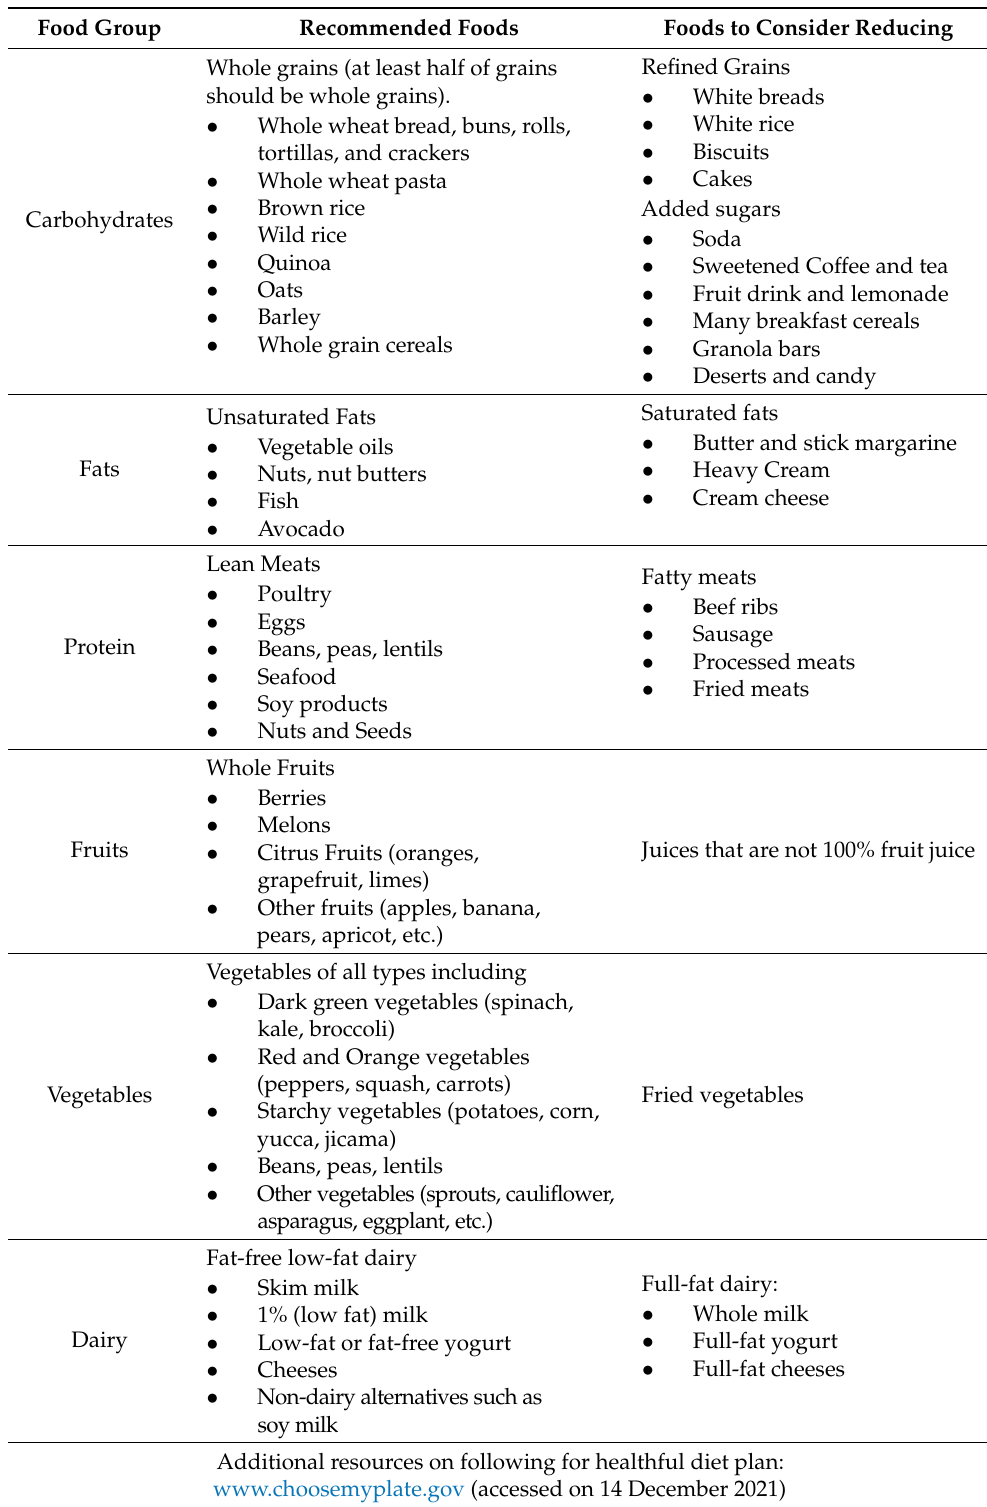
Table 3. Dietary modifications for a generally healthful eating pattern. Food Group Recommended Foods Foods to Consider Reducing Whole grains (at least half of grains should be whole